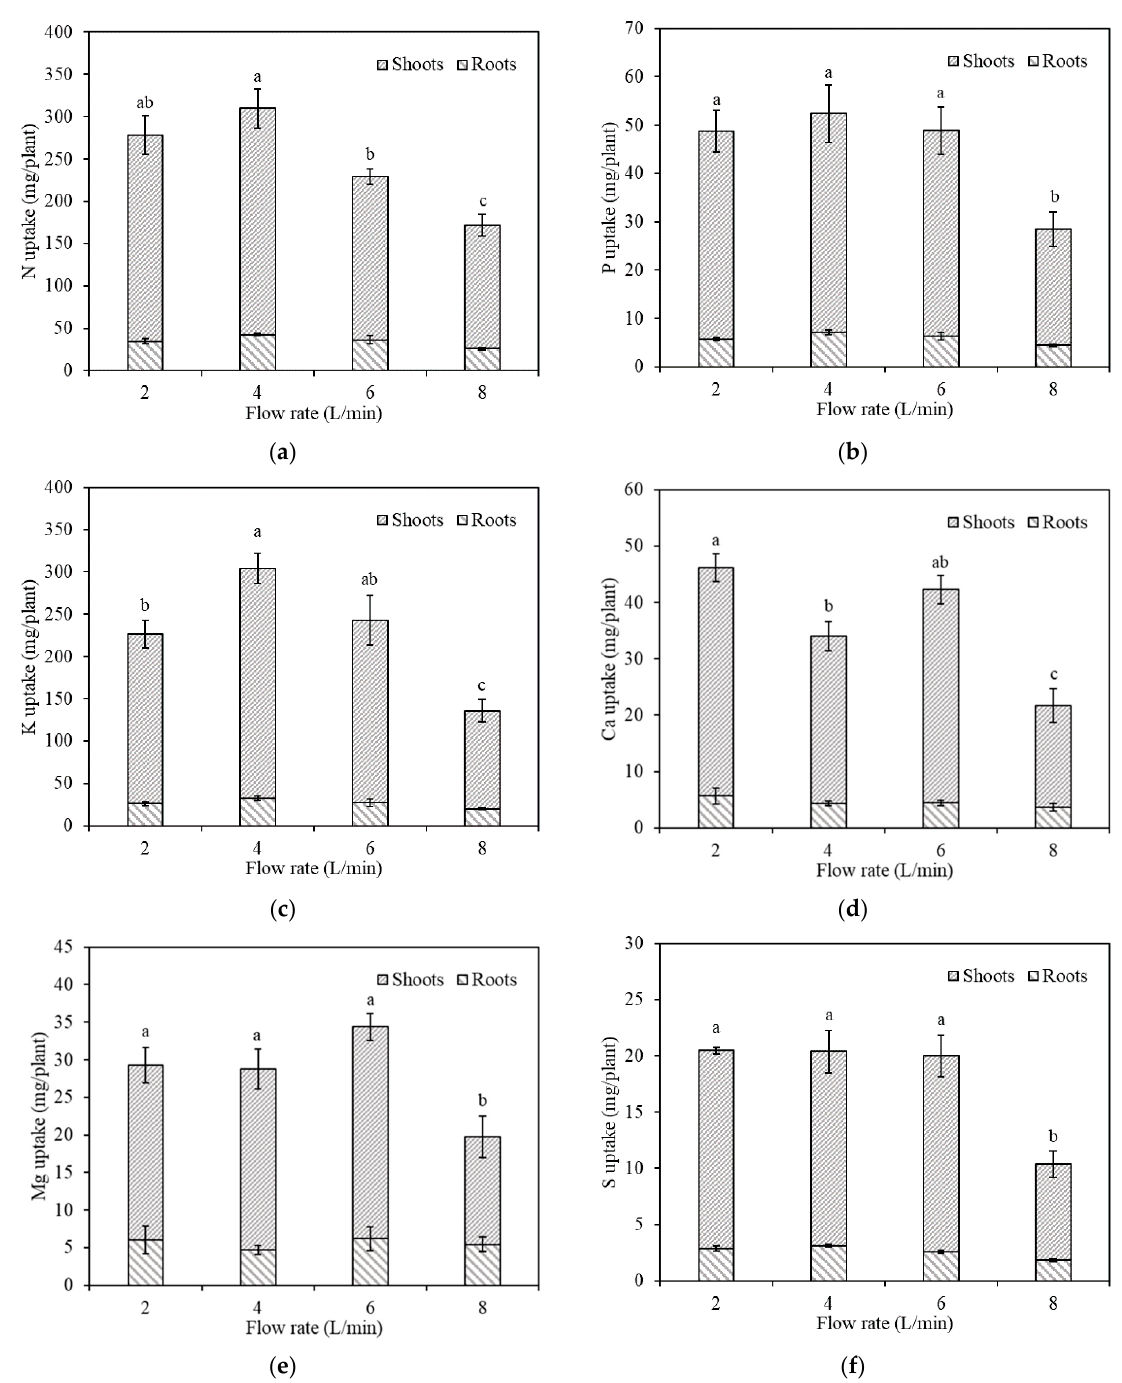
Figure 2. Nutrient uptake of plants under different flow rates. ( a ) Nitrogen uptake by a whole plant; ( b ) phosphorus uptake by a whole plant; ( c ) potassium uptake by a whole plant; ( d ) calcium uptake by a whole plant; ( e ) magnesium uptake by a whole plant; ( f ) sulfur uptake by a whole plant. There were significant differences in the bars marked with different letters ( p < 0.05). Data are expressed as means ± standard error ( n = 4).